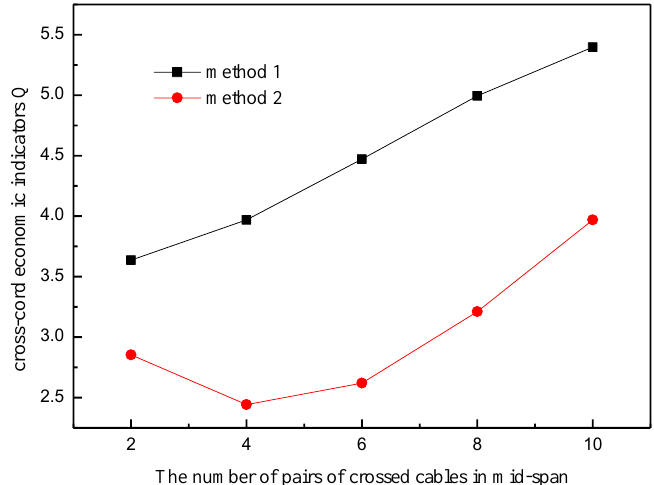
Figure 11. Comparison of economic indicator of crossed cables.